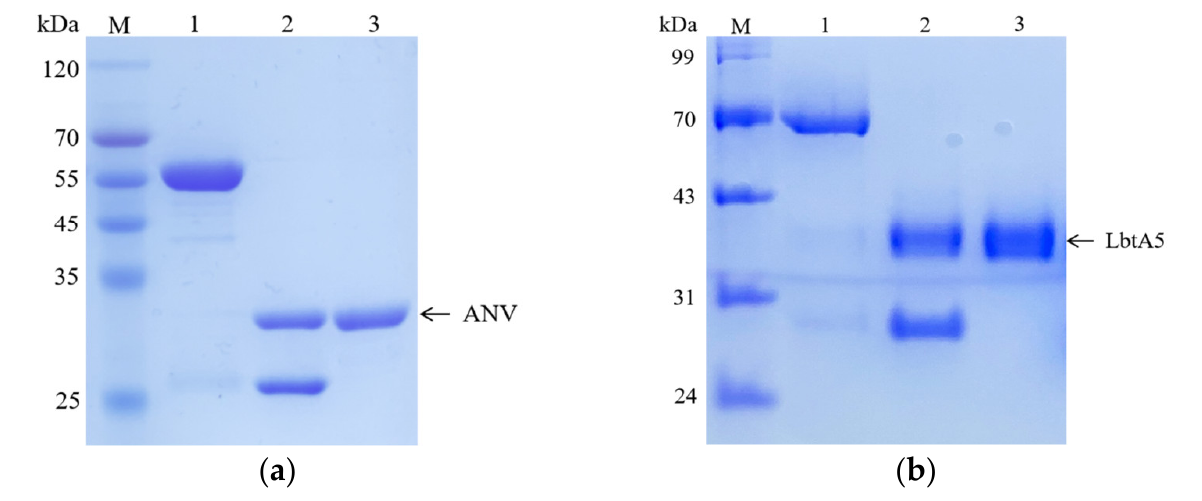
Figure 1. Analyses of the purified LbtA5 and ANV by SDS–PAGE on a 12% resolving gel. The gel was stained with Coomassie blue R-250. ( a ) Lane 1: purified GST-ANV (62.76 kDa); Lane 2: ANV (36.35 kDa) and GST isolated after PSP enzymatic digestion; Lane 3: purified ANV; ( b ) Lane 1: pu- rified GST-LbtA5 (67.37 kDa); Lane 2: LbtA5 (40.96 kDa) and GST (26.43 kDa) isolated after PSP enzymatic digestion; Lane 3: purified LbtA5.